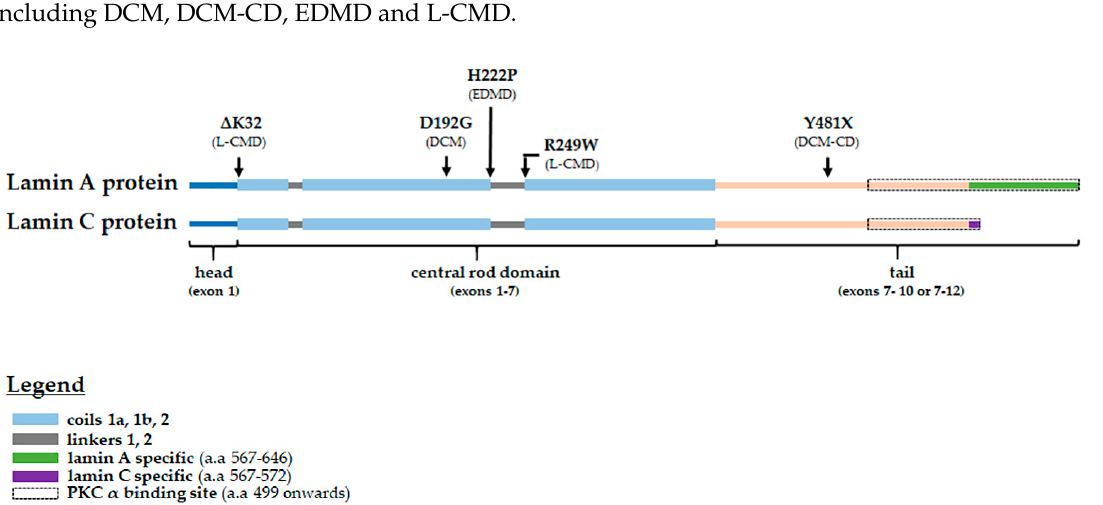
Figure 1. Lamin A / C protein schematic showing the locations of the pathogenic amino acid changes studied, their corresponding phenotypes and the PKC- α binding site (indicated by the black dotted line box). DCM—dilated cardiomyopathy; EDMD—Emery–Dreifuss muscular dystrophy;